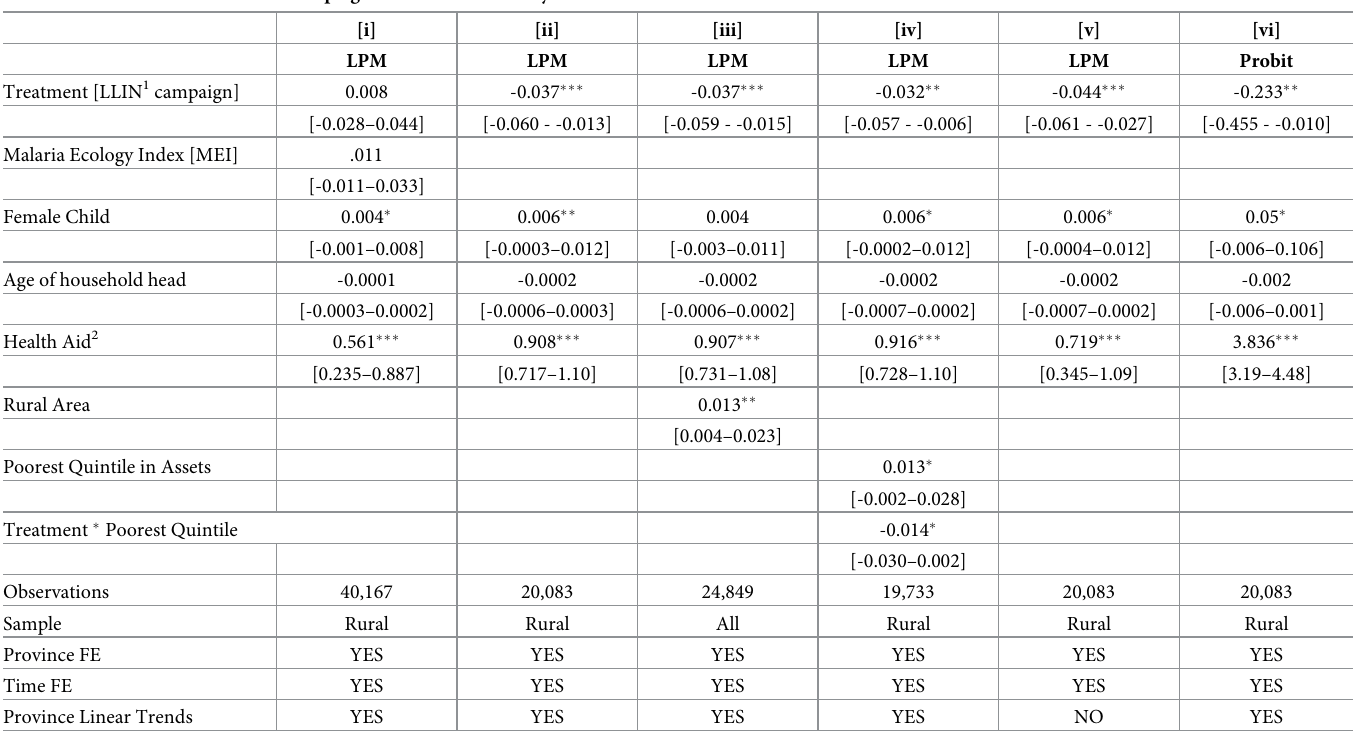
Table 2. Treatment effect of LLIN campaign on under-5 mortality